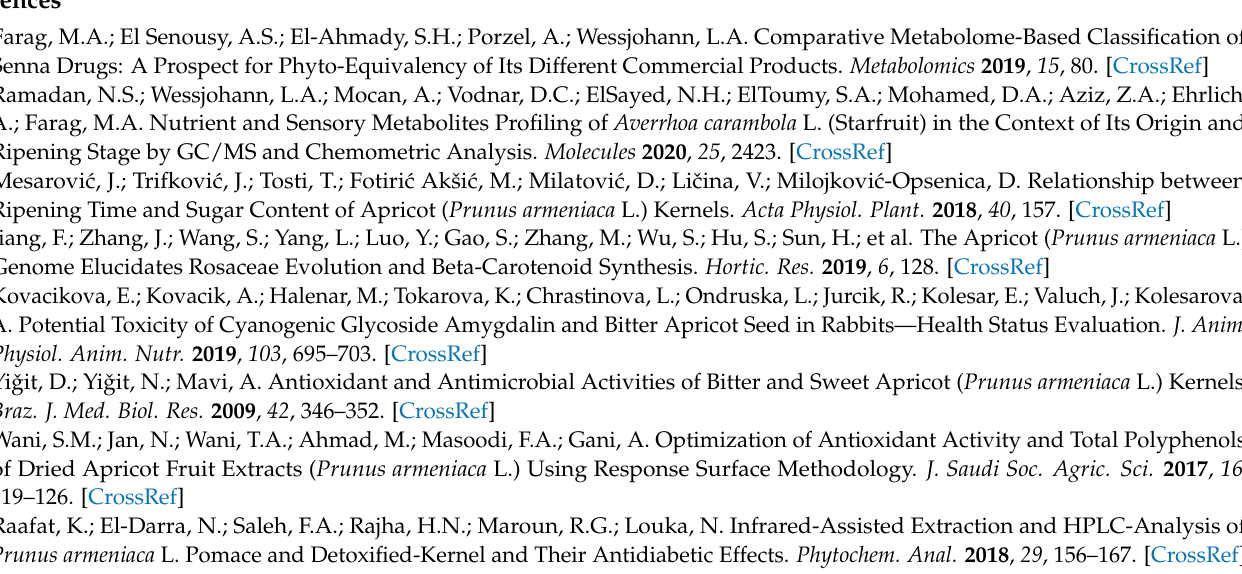
The metabolome clusters are placed in two dimensional space at the distinct locations defined by two vectors of principal component PC1 = 64% and PC2 = 18%.; Figure S2: Principal component analyses of silylated fruit of Apricot methanol extracts as analyzed by GC-MS ( n = 3). (A) Score plot of PC1 vs. PC2 scores. (B) Loading plot for PC1 and PC2 contributing mass peaks and their assignments. The metabolome clusters are placed in two dimensional space at the distinct locations defined by two vectors of principal component PC1 = 62% and PC2 = 18%; Figure S3: Unsupervised multivariate data analyses of the studied apricot fruit cultivars derived from modeling volatile profiles analyzed via GC–MS ( n = 3). (A) PCA score plot of PC1 vs. PC2 scores. (B) The respective loading plot for PC1 and PC2, providing their assignments. The metabolome clusters are placed in two-dimensional space at the distinct locations defined by two vectors of principal component PC1 = 34% and PC2 = 23%. (C) HCA plot; Figure S4: GC–MS-based OPLS-DA score plot (A) derived from modeling volatiles of sweet apricot fruit cultivar versus all bitter apricot fruit cultivars ( n = 3). The respective loading S-plots (B) showing the covariance p (1) against the correlation p (cor) (1) of the variables of the discriminating component of the OPLS-DA model. Cut-off values of p = 0.02 were used. Designated variables are highlighted and identifications are discussed in the